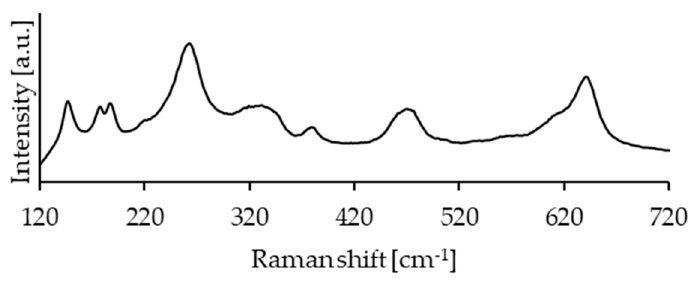
Figure 2. Representative Raman spectrum (phase transformation to the monoclinic is evident from the appearance of the Raman twin band in the frequency range between 170 and 200 cm − 1 ).